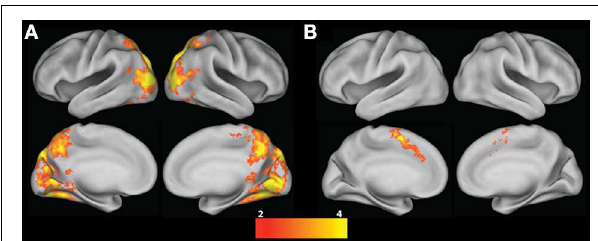
FIGURE 4 | Risky choice Parametric contrast. (A) Conjunction between BART and ART; (B) ART vs. BART group contrast. All contrasts are corrected for whole-brain multiple comparisons; statistical maps were projected onto an average cortical surface using CARET (Right hemisphere = Right side of the image). The color scale represents